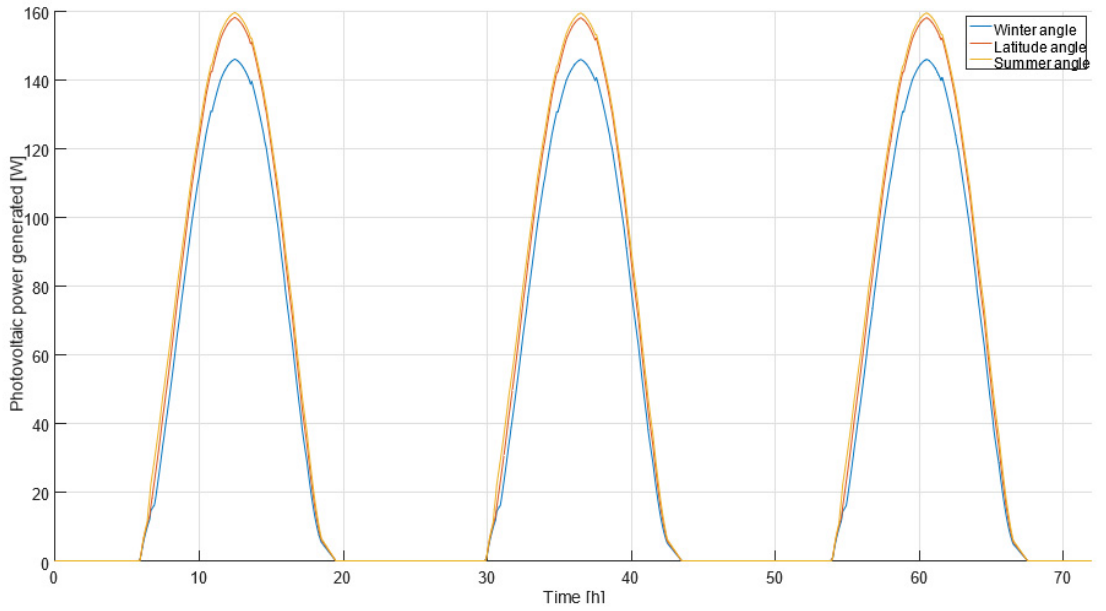
Figure 18. Energy generated by the photovoltaic array for the 3 different solar tilt angles between the 29 and 31 January.